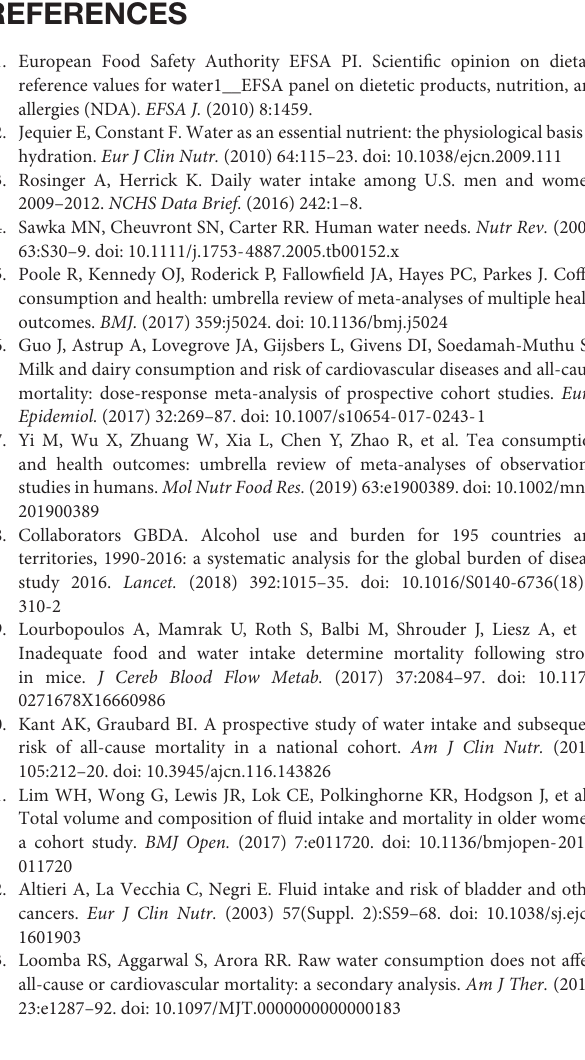
Supplementary Figure 4 | The dose–response relationships of the amount of water intake [expressed by total water (A) , plain water (B) , beverage water (C) , and food water (D) ] with the mortality risk due to all causes in women clarified by restricted cubic spline plots. Supplementary Figure 5 | The dose–response relationships of the amount of water intake [expressed by total water (A) , plain water (B) , beverage water (C) , and food water (D) ] with the mortality risk due to malignant neoplasms/cancer in men clarified by restricted cubic spline plots. Supplementary Figure 6 | The dose–response relationships of the amount of water intake [expressed by total water (A) , plain water (B) , beverage water (C) , and food water (D) ] with the mortality risk due to malignant neoplasms/cancer in women clarified by restricted cubic spline plots. Supplementary Figure 7 | The dose–response relationships of the amount of water intake [expressed by total water (A) , plain water (B) , beverage water (C) , and food water (D) ] with the mortality risk due to heart diseases in men clarified by restricted cubic spline plots. Supplementary Figure 8 | The dose–response relationships of the amount of water intake [expressed by total water (A) , plain water (B) , beverage water (C) , and food water (D) ] with the mortality risk due to heart diseases in women clarified by restricted cubic spline